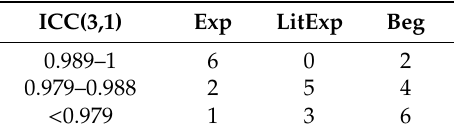
Figure 9. Intraclass correlation coefficient and normalized mean Euclidean distance. Displayed are the Ms, SDs (error bars) and 95%-CIs of ( a ) the ICC(3,1) and ( b ) the MED (%) comparing the groups experienced (Exp; green), little experienced (LitExp; yellow) and beginners (Beg; orange). For the significant comparisons adjusted p -values are given. Table 4. Distribution of testers ( n ) according to the amount of ICC(3,1) sorted by groups experienced (Exp), little experienced (LitExp) and beginners